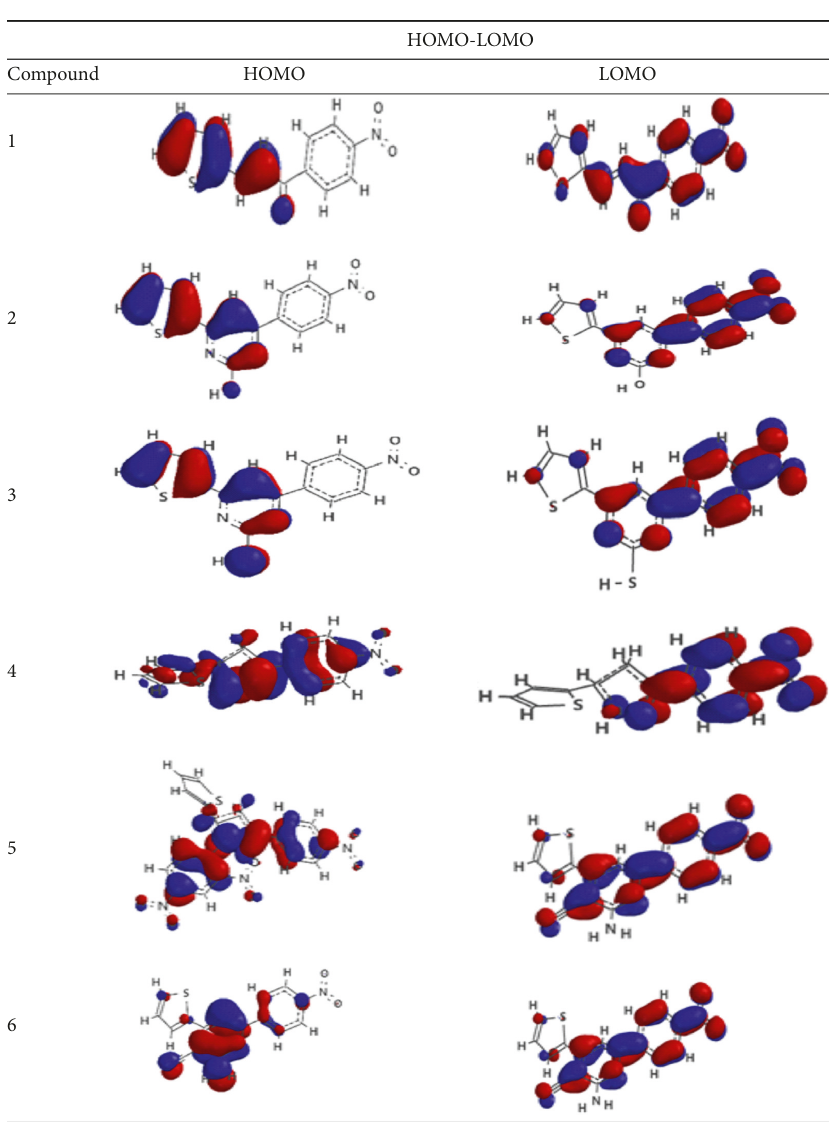
Figure 2: HOMO-LUMO frontier orbital of the newly synthesized molecules and the starting molecule (red color represents negative phase while the blue color points to the positive one). All molecules containing one or three nitro groups are of noticeable charge transfer character showing larger contribution of the orbitals localized on the nitro groups in the LUMOs.